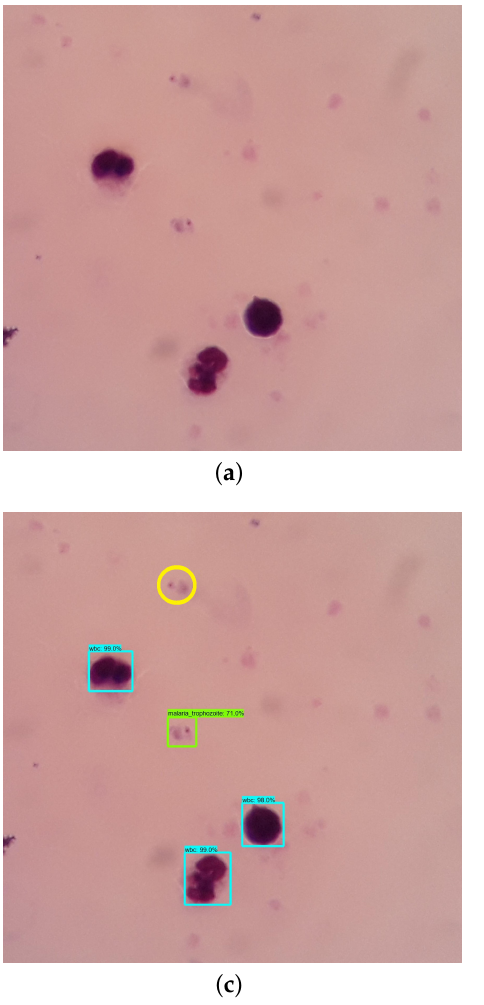
Figure 5. Results for detection with Faster R-CNN ( b ) and SSD ( c ) for a sample image ( a ). The blue rectangles indicate WBCs, and the green rectangles indicate malaria trophozoites. The yellow circle indicates a False